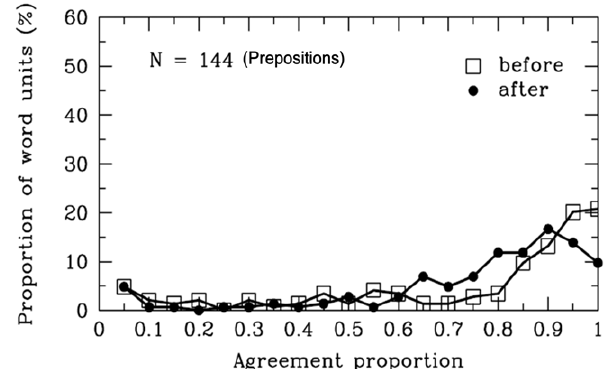
Figure 7. Prepositions. Frequency distribution of agreement proportions for word boundaries before (open squares) and after (filled circles) the prepositions. The y-axis represents the proportion of SWU. The number of SWU is also represented in the figure.